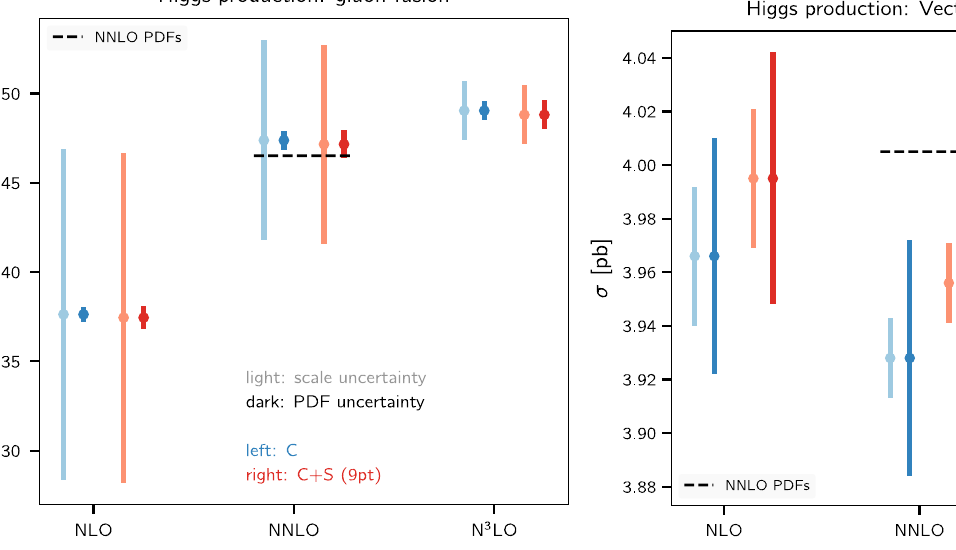
Fig. 21 Graphical representation of the results of Tables 9 and 10. At each perturbative order the pair of uncertainty bands on the left (blue) is computed with PDFs based on the experimental covariance matrix C , whilethepairofuncertaintybandsontheright(red)withPDFsbasedon the combined experimental and theoretical covariance matrix C + S (9-